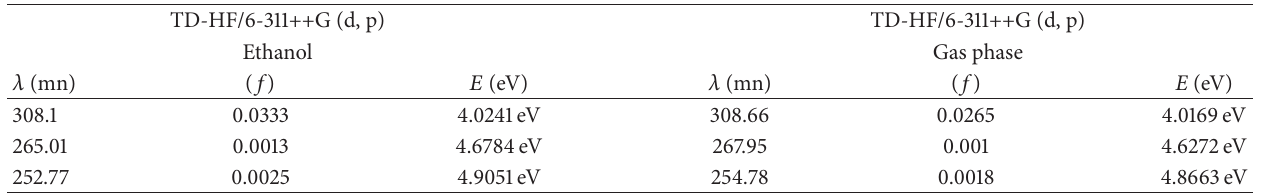
Table 6: Calculated absorption wavelength (nm), excitation energies E (eV), and oscillator strengths (𝑓) of benzothiazole.